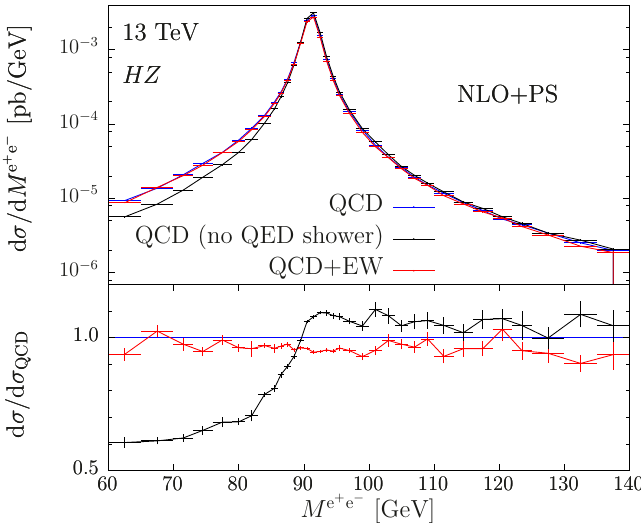
Figure 16. NLO+PS predictions for the invariant mass of the reconstructed leptonic pair in HZ production. Same curves and labels as in (cid:12)gure 15. For comparison, the result obtained by showering the QCD-corrected events without QED shower in Pythia 8.1 is also plotted.